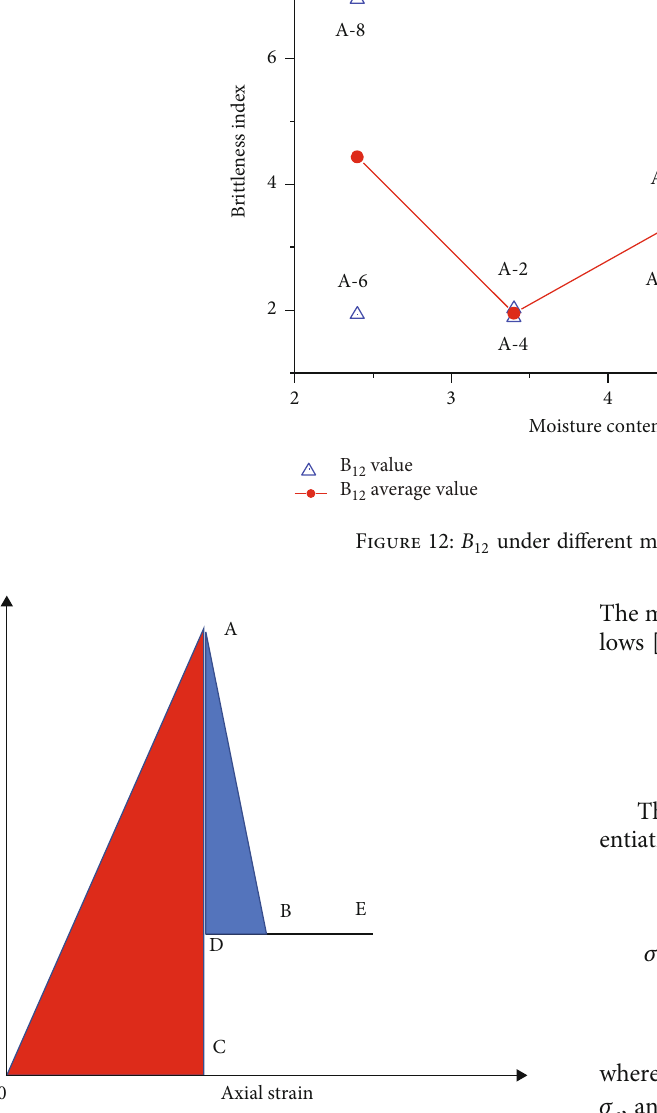
Figure 13: Schematic diagram of brittleness index B